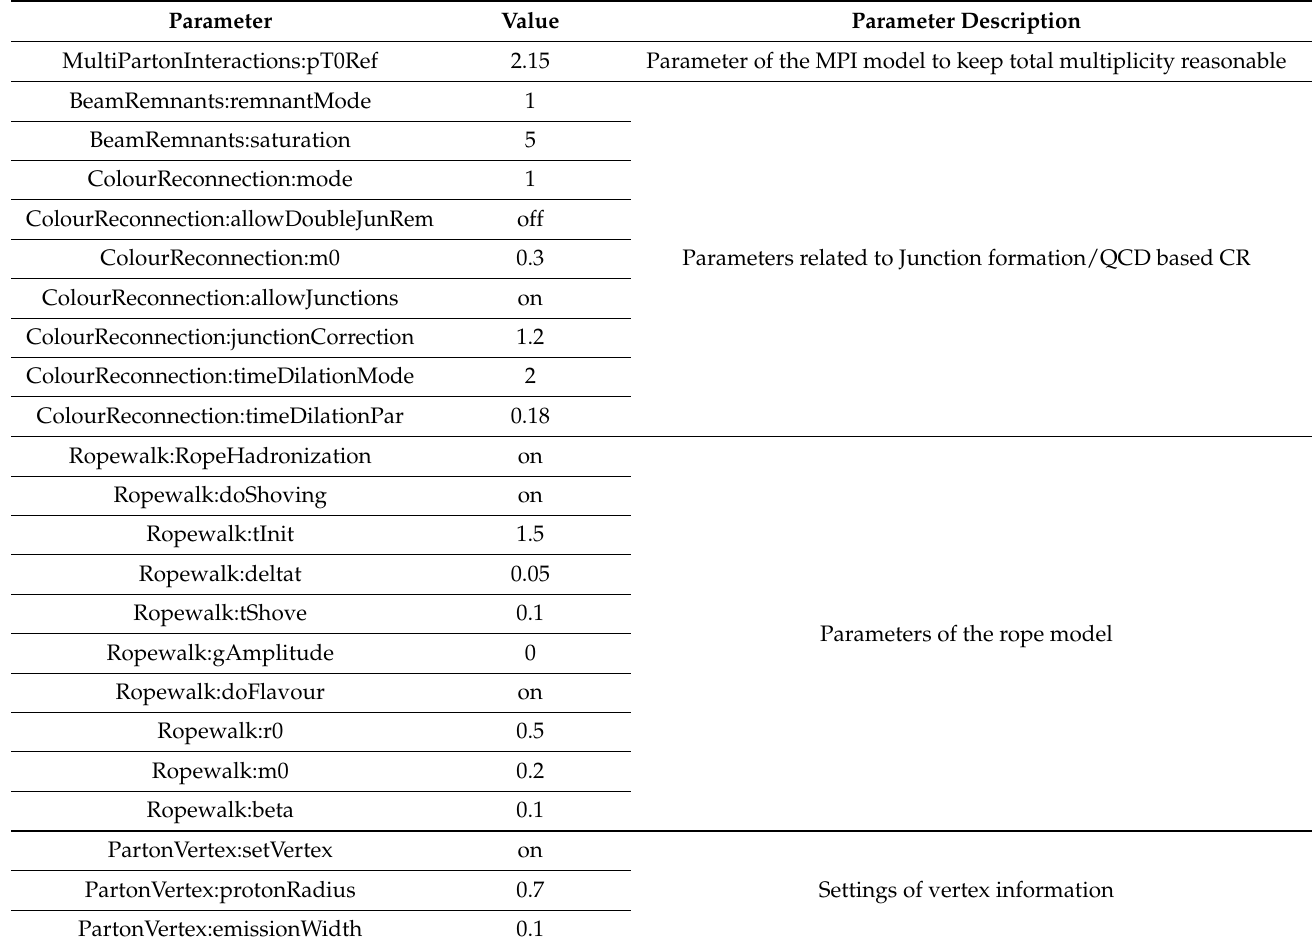
Table 3. Configuration parameters for PYTHIA8 rope